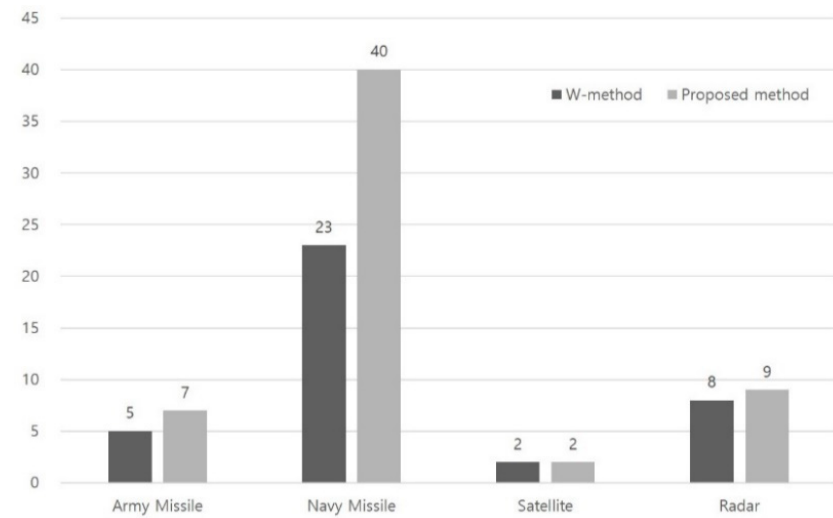
Figure 14. No. of Errors of case studies.